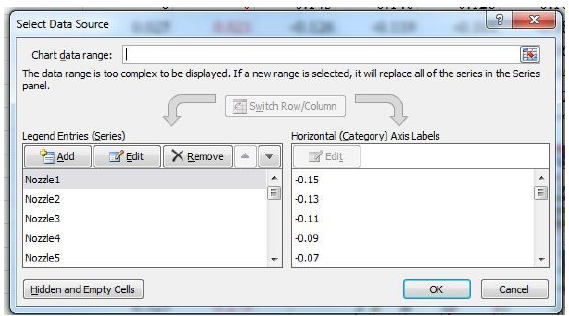
Fig. 8 . Dialogue window Select Data Source